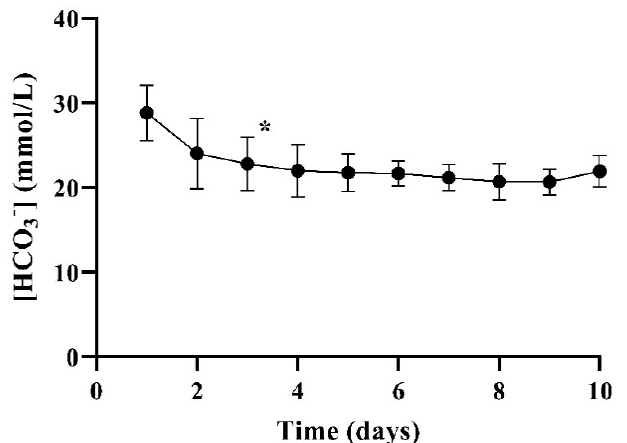
Figure 4. Mean (±SD) plasma bicarbonate concentrations after oral administration of acetazolamide 500 mg/day and ramipril 1.25 mg/day for 3–10 days ( n = 10 courses in 3 goats, 1–6 courses per goat) is presented. * Day 1 vs. 3: p < 0.001 (paired t- test).